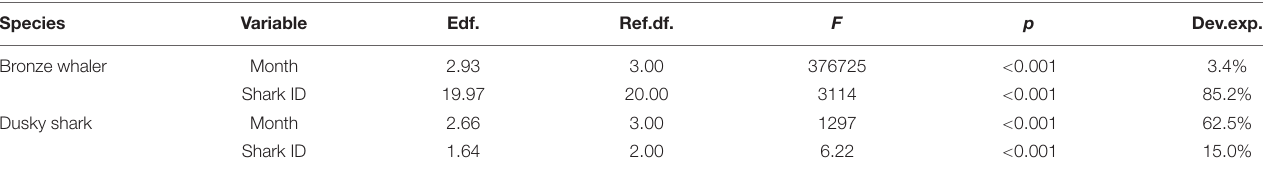
TABLE 2 | Generalized Additive Mixed Models (GAMM) of longitude variation as a function of month for bronze whaler and dusky shark including shark identification number (Shark ID) as random effects. Species Variable Edf. Ref.df.